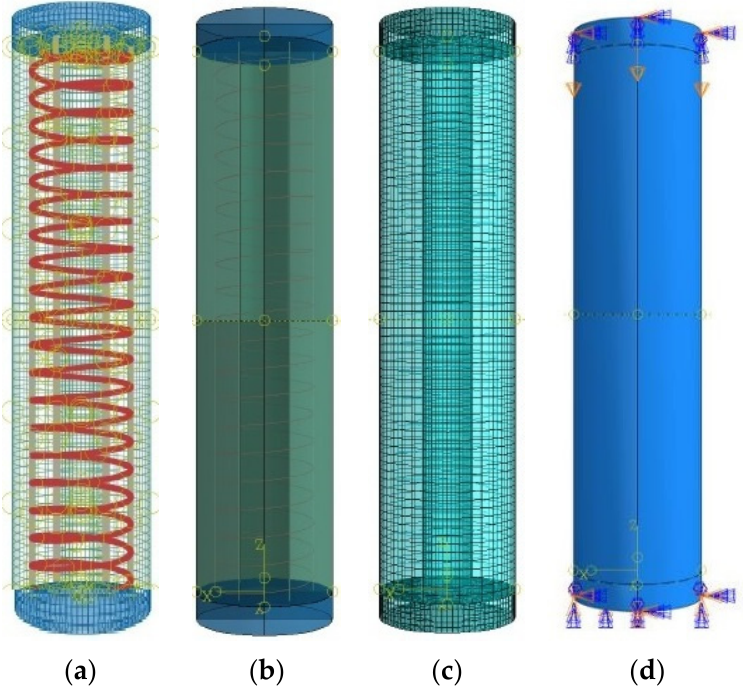
Figure 2. Simulated model of HCCs showing GFRP reinforcement ( a ); Material sections ( b ); Element meshing ( c ), and Boundary condition ( d ). To be able to describe relationships between the elements of the structures, the figure also shows a three-dimensional coordinate axis system. Table 3. Properties of finite element (FE) simulations.